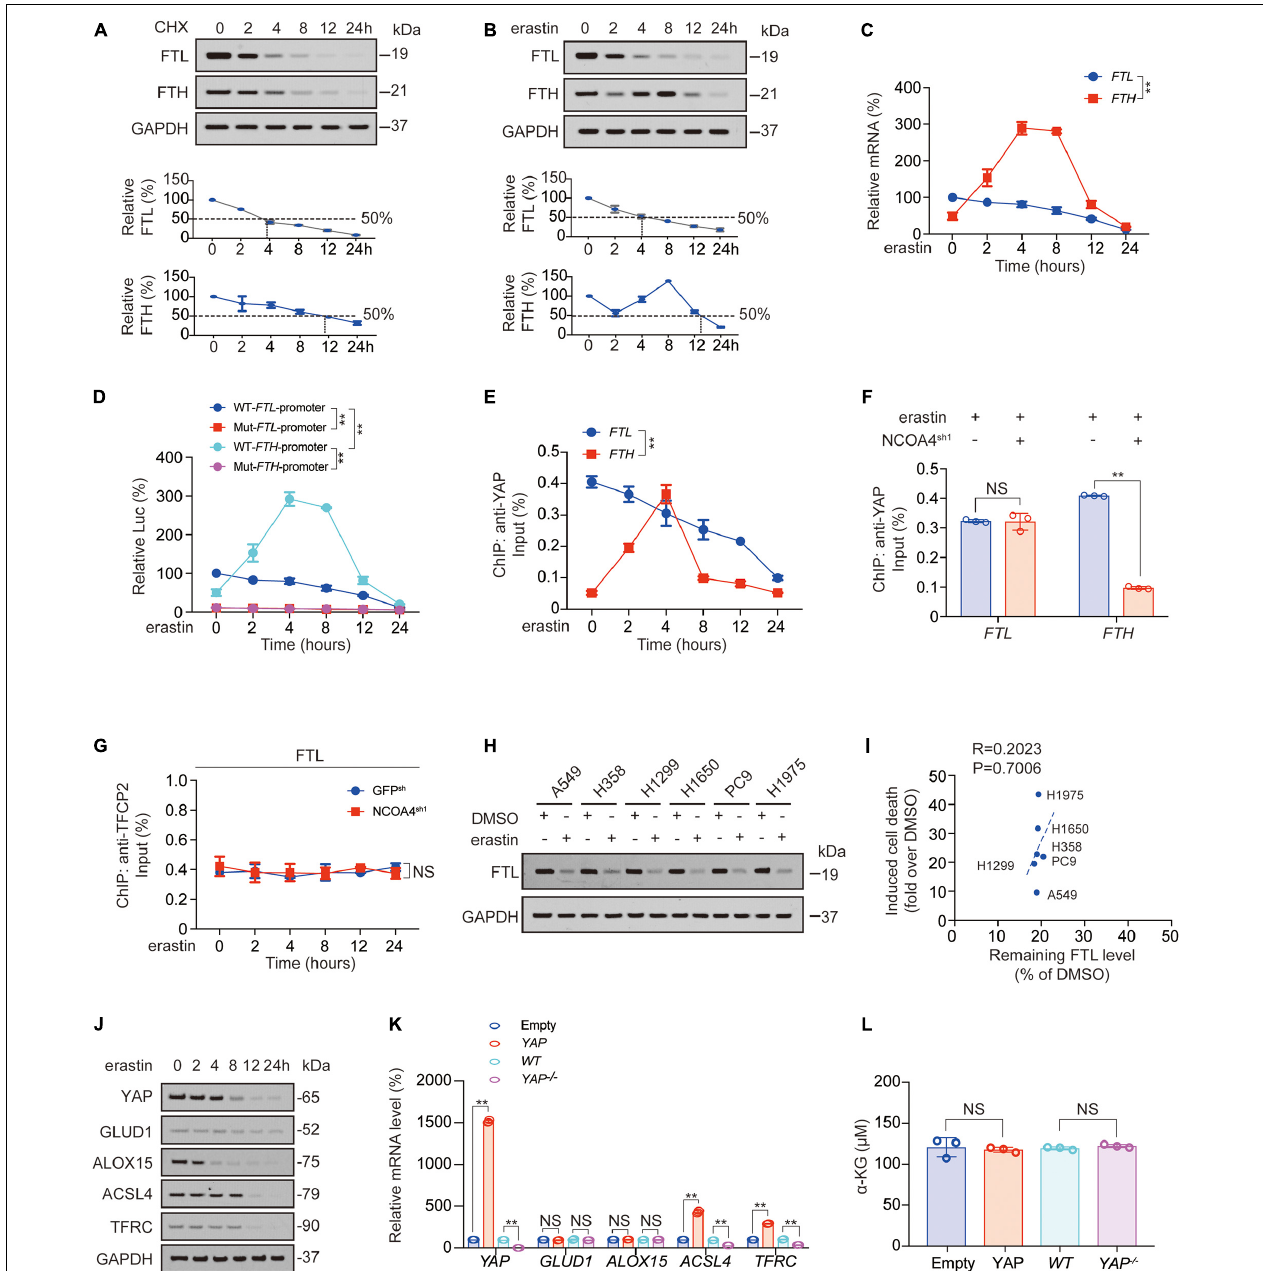
FIGURE 5 | FTL and FTH were differentially regulated after erastin treatment. (A,B) FTL and FTH were measured by IB in PC9 cells treated with CHX (10 µ g/ml, A ) or erastin (10 µ M, B ) for indicated hours. The relative protein levels of FTL and FTH were shown as the ratios to GAPDH, and the “0h” points were arbitrarily set to 100%. (C) mRNA level of FTH and FTL in PC9 cells treated with erastin (10 µ M) for indicated hours. (D) WT or TFCP2 (FOXA1)-binding motif mutant (Mut) FTL / FTH promoter Luc activity were measured in PC9 cells treated with erastin (10 µ M) for indicated hours. (E) Enrichment of YAP at TFCP2 (FOXA1)-binding motif within the FTL or FTH promoter in PC9 cells was measured by ChIP-qPCR after erastin treatment (10 µ M) for indicated hours. (F) Enrichment of YAP at TFCP2 (FOXA1)-binding motif within the FTL or FTH promoter in erastin (10 µ M, 4 h) treated PC9 cells with or without NCOA4 knockdown was measured by ChIP-qPCR. (G) Enrichment of TFCP2 at TFCP2 (FOXA1)-binding motif within the FTL promoter in PC9 cells with or without NCOA4 knockdown was measured by ChIP-qPCR after erastin treatment (10 µ M) for indicated hours. (H) FTL was measured by IB in indicated LUAD cells with or without erastin (10 µ M, 24 h) treatment. (I) Correlation between induced cell death and remaining FTL level after erastin (10 µ M, 24 h) treatment for 24 h. Induced cell death and remaining FTL level was calculated as fold or percentage to the ones treated with DMSO. (J) YAP, GLUD1, ALOX15, ACSL4 and TFRC expression were measured using IB in PC9 cells with erastin (10 µ M) treatment for indicated hours. (K,L) YAP, GLUD1, ALOX15, ACSL4 and TFRC mRNA level (K) and α -KG concentration (L) were measured in PC9 cells with YAP overexpressed or knocked down. The data are shown as the mean ± SD from three biological replicates (including IB). ** P < 0.01 indicates statistical significance. Data in (C–E , G) were analyzed using a two-way ANOVA test. Data in (F , K , L) were analyzed using student’s t -test. Data in I were analyzed using Spearman rank-correlation analysis.